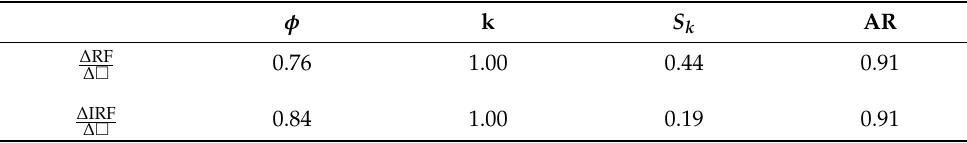
Table 3. Dimensionless results of sensitivity